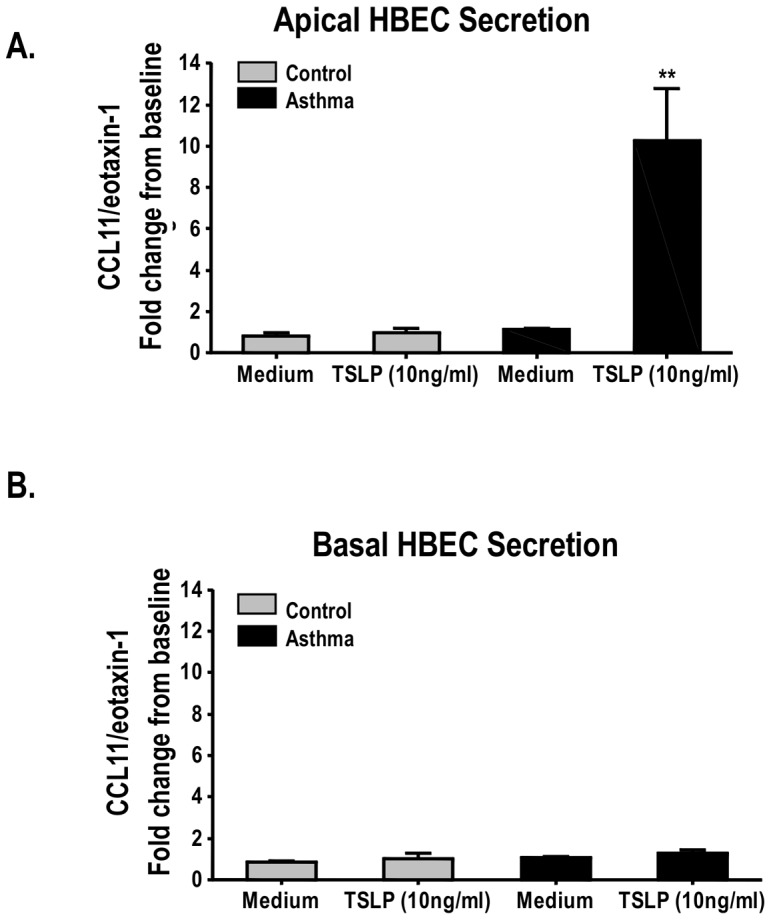
Unidirectional TSLP-induced secretion of CCL11/eotaxin-1 in HBEC.CCL11/eotaxin-1 is secreted apically (A) but not basally (B) by ALI-differentiated HBEC treated with TSLP (apical 10 ng/ml×48 h). Bars represent means ± SE of triplicate values from 3 experiments done with cells from 3 controls and 3 asthmatic donors. Results are expressed as fold increase from baseline relative to control values (medium alone). **P<0.01, *P<0.05.